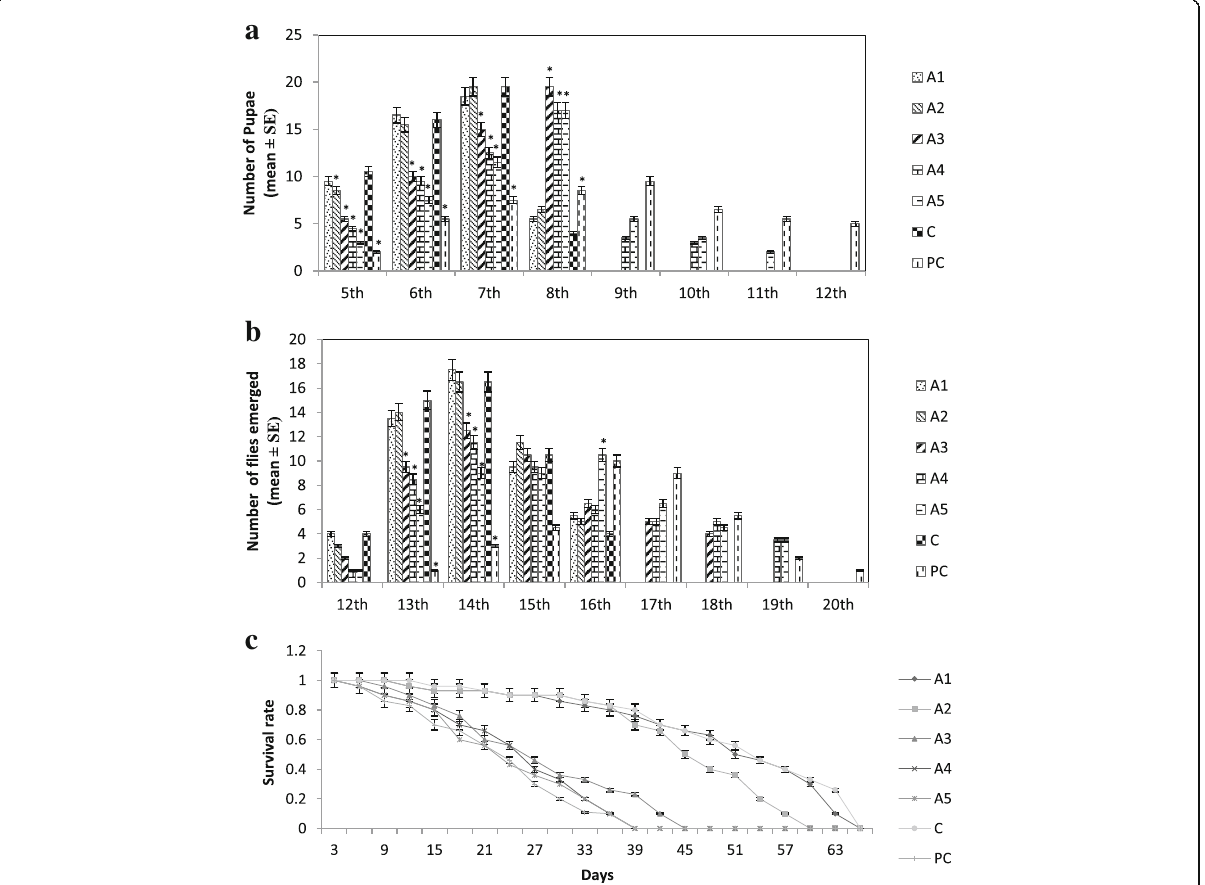
Fig. 6 Effect on the pupation ( a ), emergence ( b ) and life span ( c ) of the flies after the exposure to various doses of arecoline (A1 = 5 μ M arecoline, A2 = 10 μ M arecoline, A3 = 20 μ M arecoline, A4 = 40 μ M arecoline, A5 = 80 μ M arecoline, PC = 10 μ l/ml methyl methanesulphonate), * significant at p < 0.05 compared to